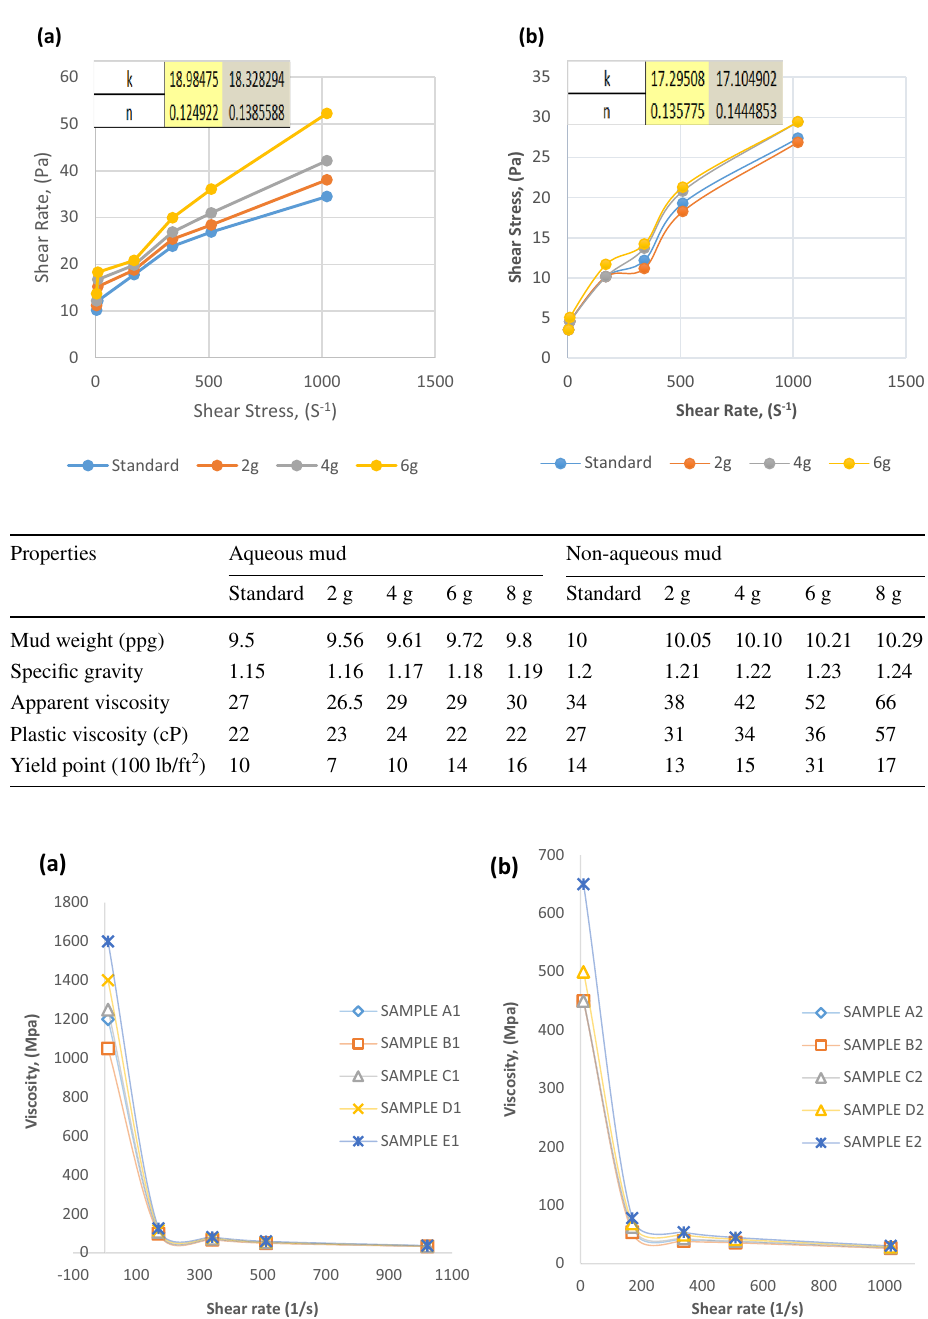
Fig. 1 The flow curve for a non-